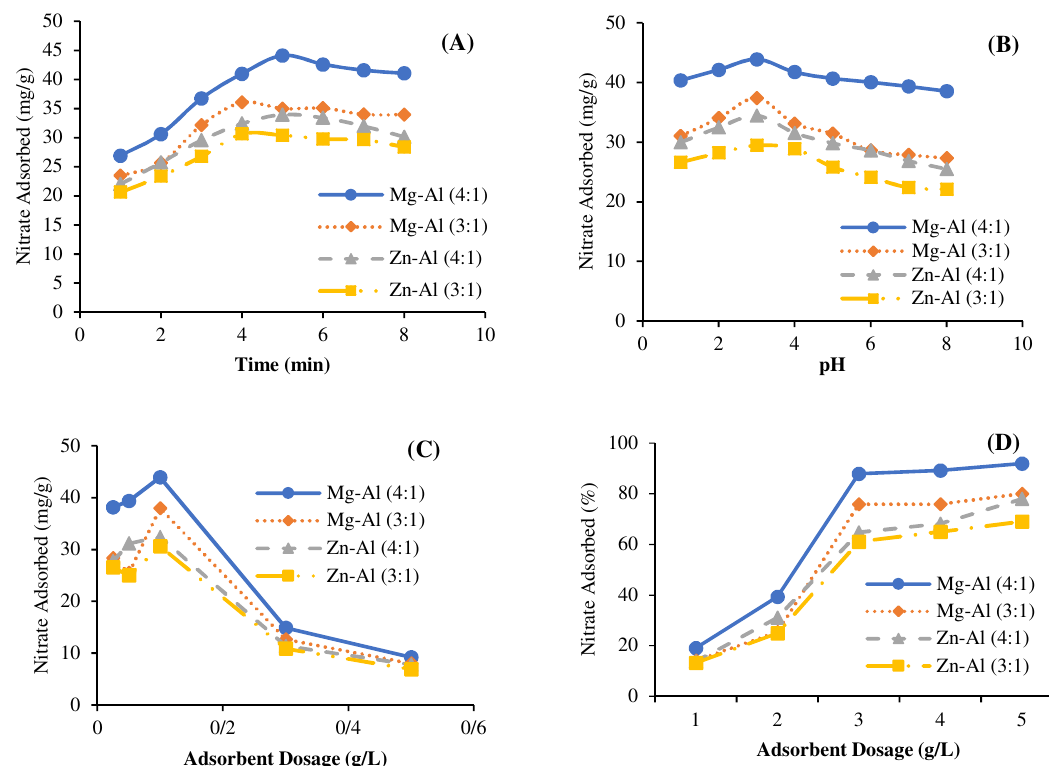
Fig. 3: (A) Impacts of contact time on the amounts of nitrate absorbed by the synthesized LDHs, (B) Impact of pH on nitrate removal by the synthesized LDHs, (C) Impacts of adsorbent dose on nitrate adsorption amount, and (D) Nitrate removal percentage by synthesized LDHs (inial concentraon: 100 mg/L, agitaon speed: 180 rpm)